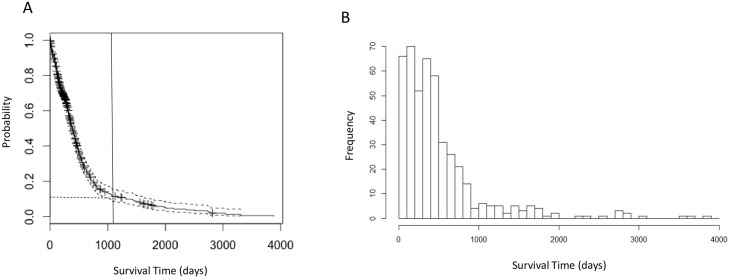
Survival time analyses of GBM patients.a. Kaplan-Meier plot of overall survival analysis of 591 GBM patients. The vertical line indicates the 3-year (1095 days) cutoff for LTS used in following analyses. The horizontal dashed line indicates 7.6% LTS patients corresponding to the cutoff. b. Histogram of survival time (in days) showing that the distribution of survival time is unimodal.